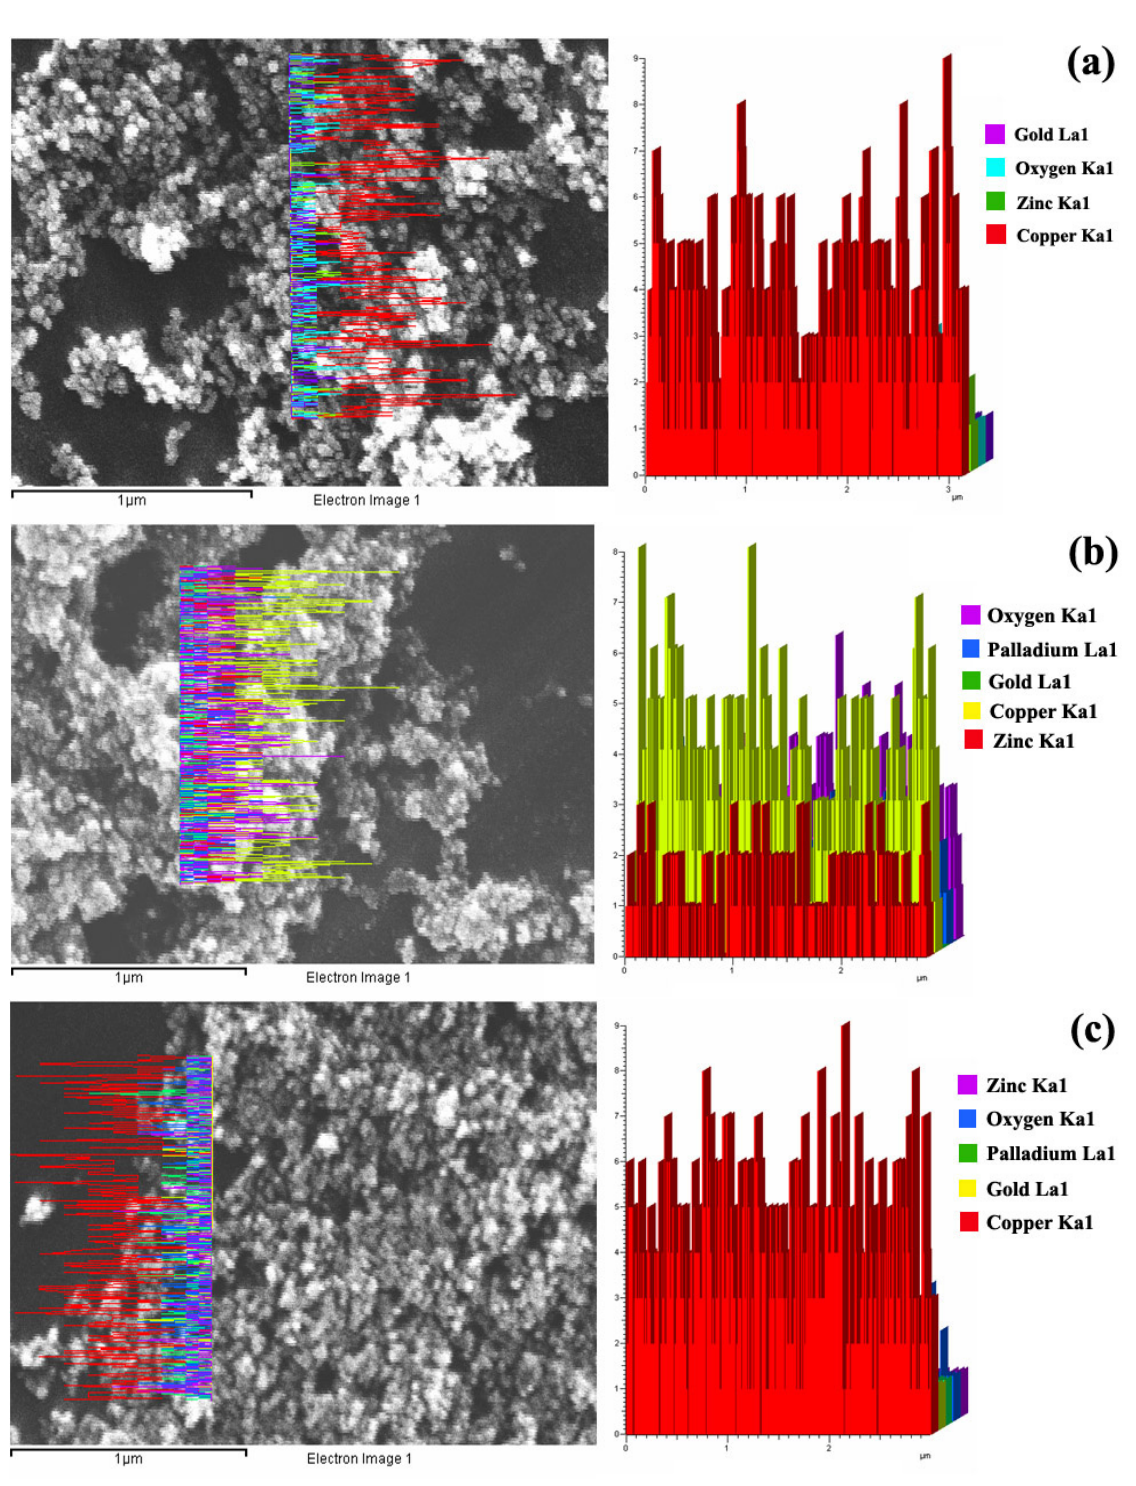
Figure 7. The EDS line scan mode-SEM analysis of flame-made (a) pure ZnO, (b) 1 mol%Pd/ZnO, and (c) 5 mol% Pd/ZnO nanoparticles. The histograms showed the elemental compositions of samples. The lines scan corresponding to Zn, O, and Pd elements, while Cu and Au caused by the contamination from the copper grid and Au sputtered prior to an